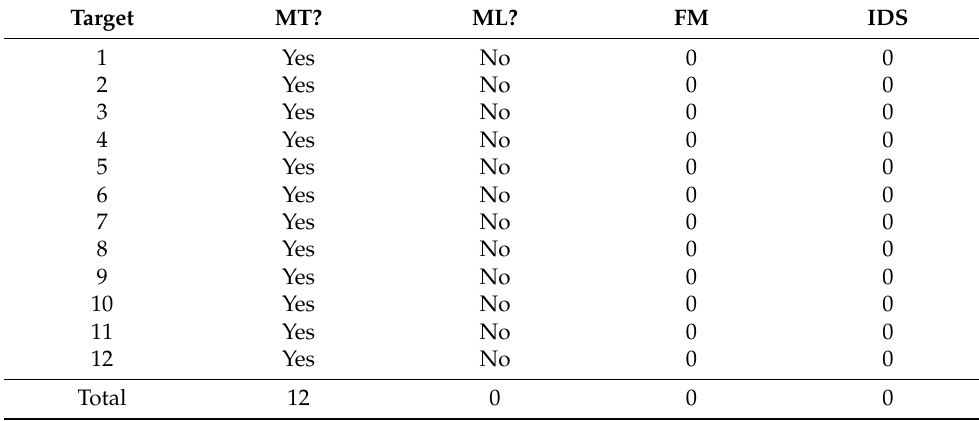
Table 5. Statistical tracking results of each target from the second test set.